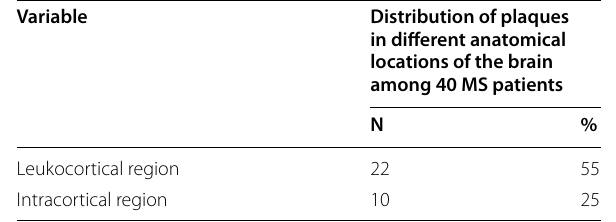
Table 4 Comparison between different MRI pulse sequences (T2, Flair and DIR) as regarding detection rate and number of cortical grey matter lesions among studied 40 MS patients: